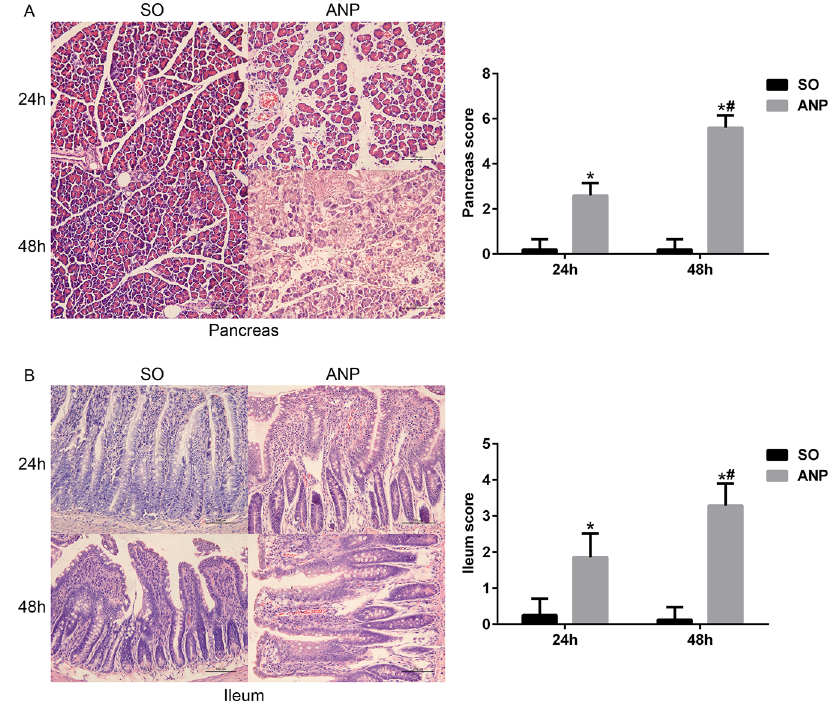
Fig 1. Pathological changesin the pancreasand the distalileum in ratswith ANP. (A) The histopathological changesandthe pathologicalscoresof the pancreasof rats (HE, × 200).(B) The histopathological changesand the pathologicalscoresof the distalileumof rats (HE, × 200). vs .SO * p < 0.05, vs .ANP24h # p < 0,05.